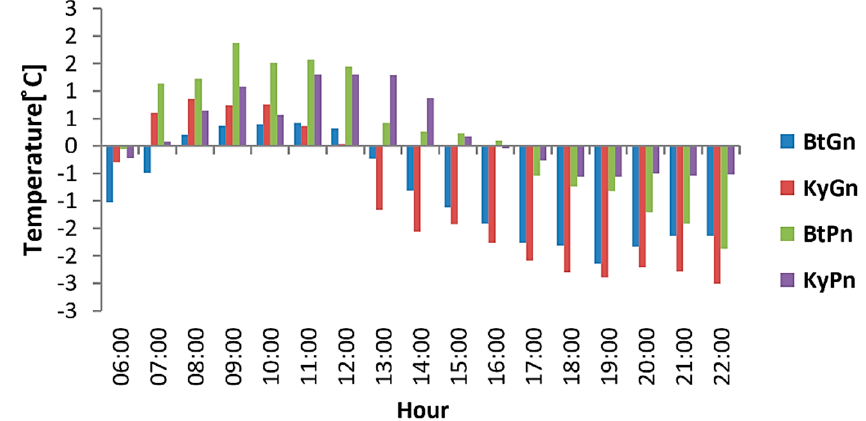
Figure 7. The difference of air temperatures in the transitional season from the dry to wet season.